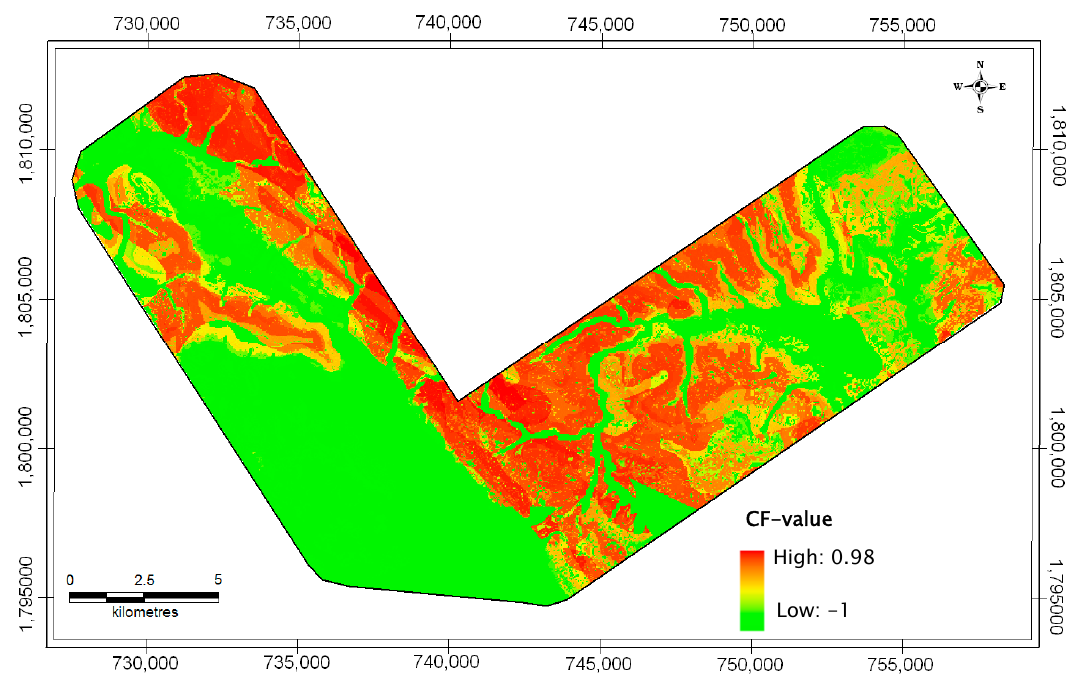
Figure 4. Landslide susceptibility map based on the certainty factor model.